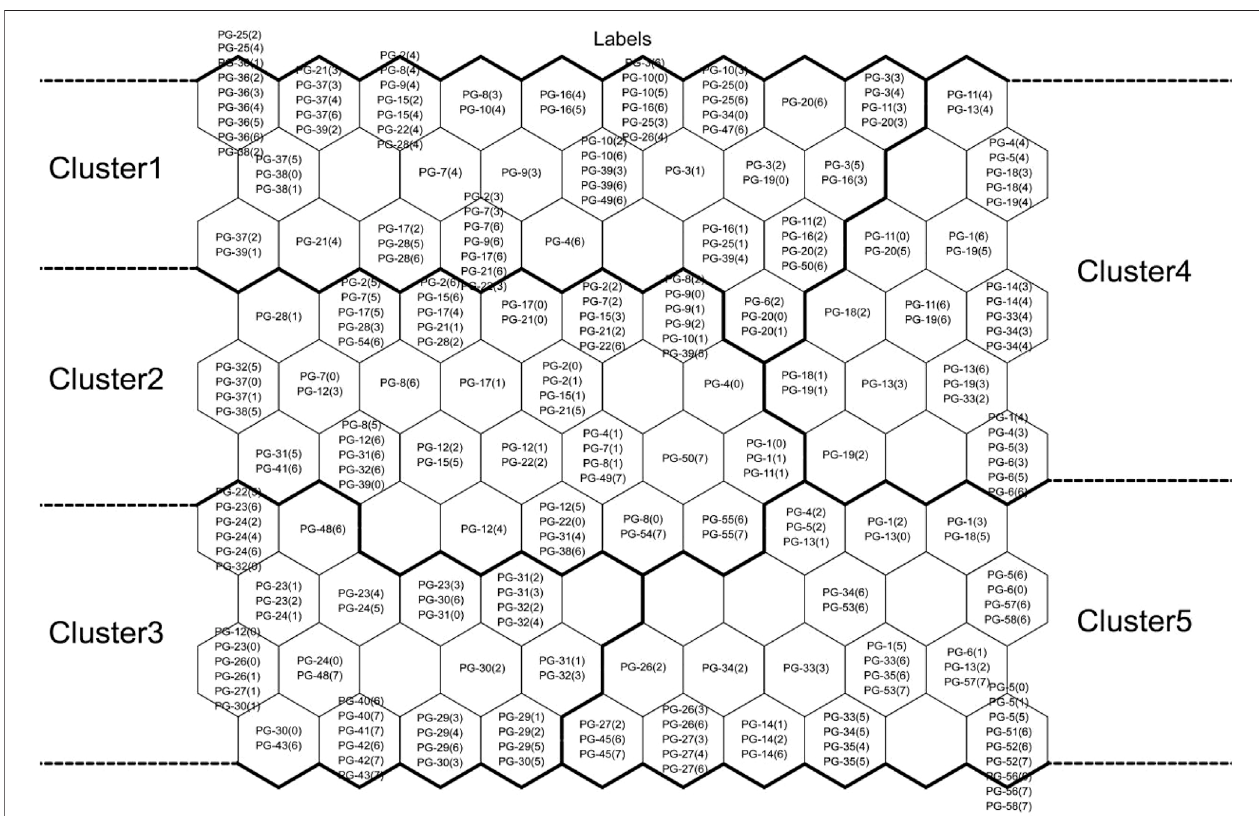
FIGURE4| Patternclassi fi cationmapofthesevenclustersbytheSOMmethod.Thenumberinthenoderepresentsthenumberofeachwell,andtheareanameis referred to as monitoring well number year (Pinggu area + year + quarter).